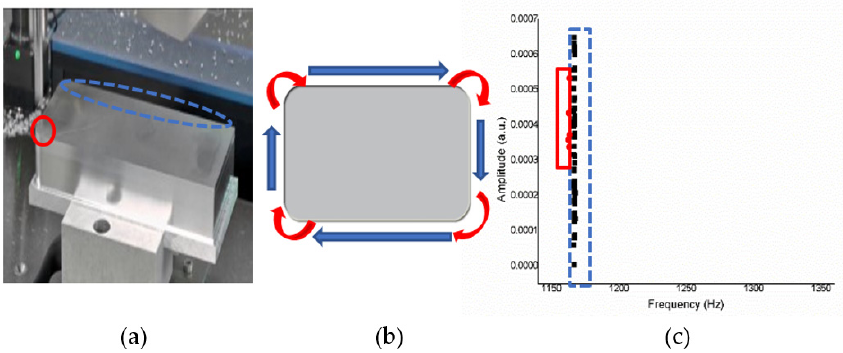
Figure 9. ( a ) Operation sketch, ( b ) trajectory of tool, ( c ) frequency of milling process for XY axes.